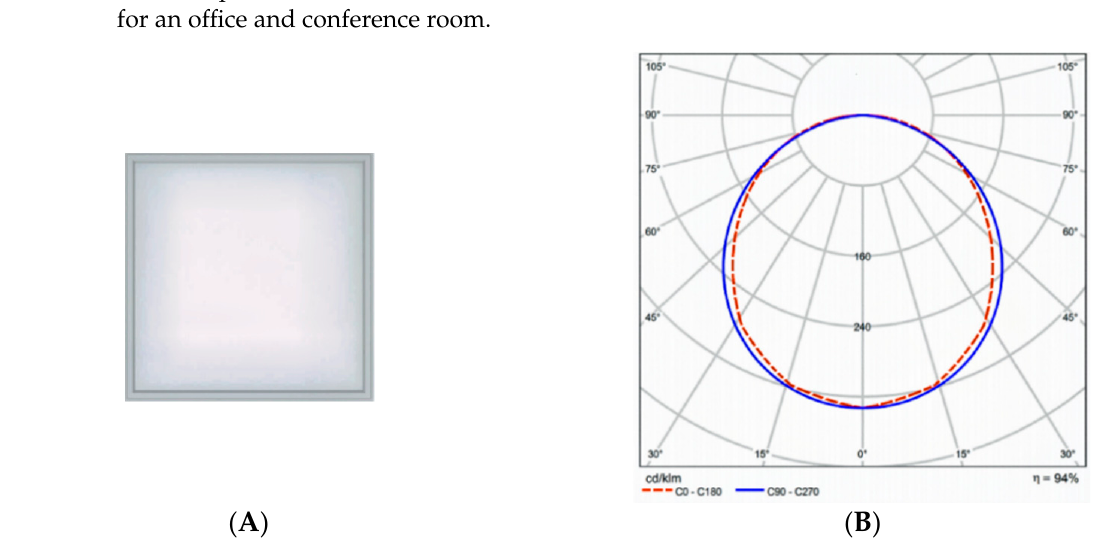
Table 4. Details of the luminaire.